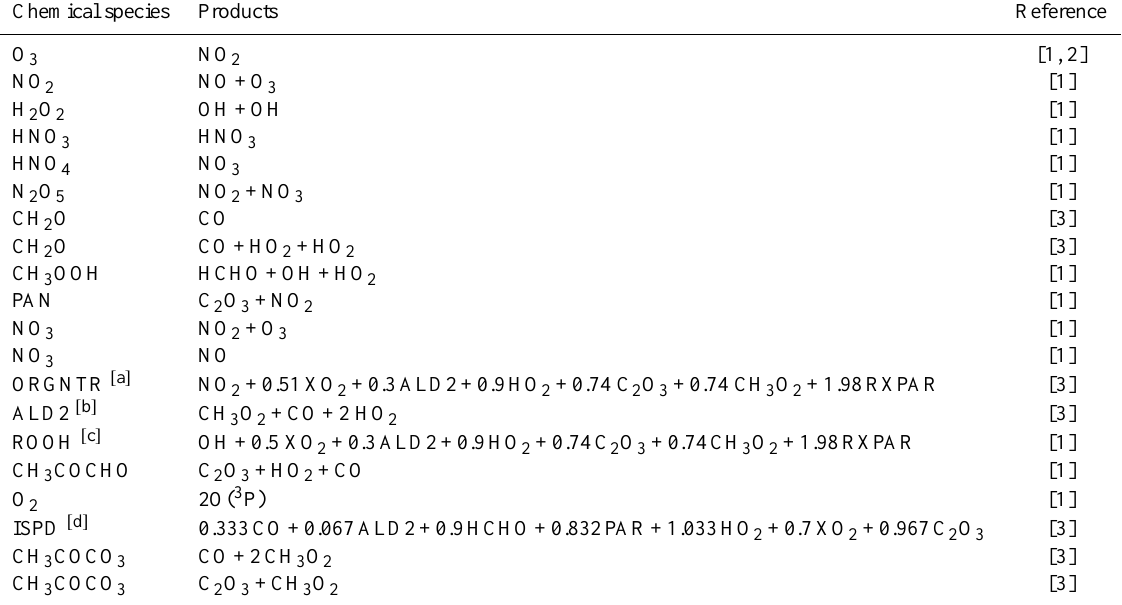
Table A2. The photolytic reaction rates included in the modified CB05 chemical mechanism. The reaction products O 2 and H 2 O are not shown. The stiochiometery of each photolytic reaction is taken from Yarwood et al. (2005) except for the photolysis of O 2 . The source of the absorption co-efficients and quantum yields are thus: [1] Sander et al. (2011), [2] Matsumi et al. (2002), [3] Atkinson et al. (2006). Further details: [a] absorption cross section for a C4 mono-nitrate are adopted (Roberts and Fayer, 1989), [b] the absorption cross section for CH 3 CHO is adopted, [c] set equal to the photolysis frequency of CH 3 OOH due a lack of laboratory measurements and [d] the absorption cross sections are set equal to an average of methyl vinyl ketone and methacrolein.